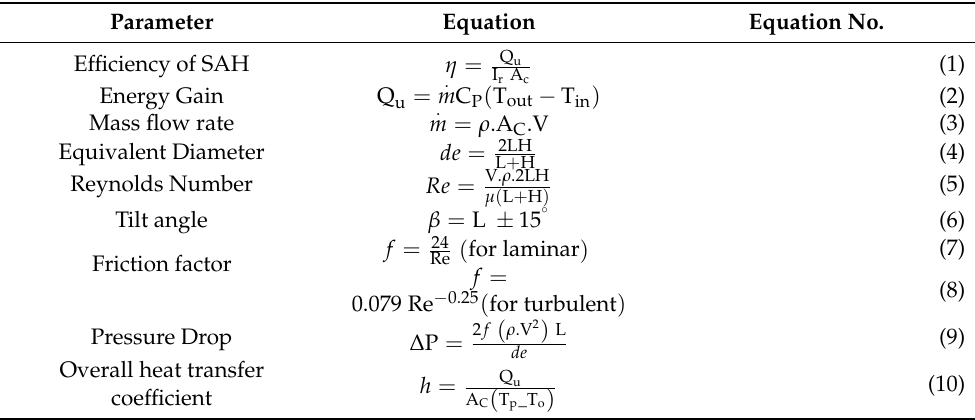
Table 1. Thermal properties of the solar air heater, [25].